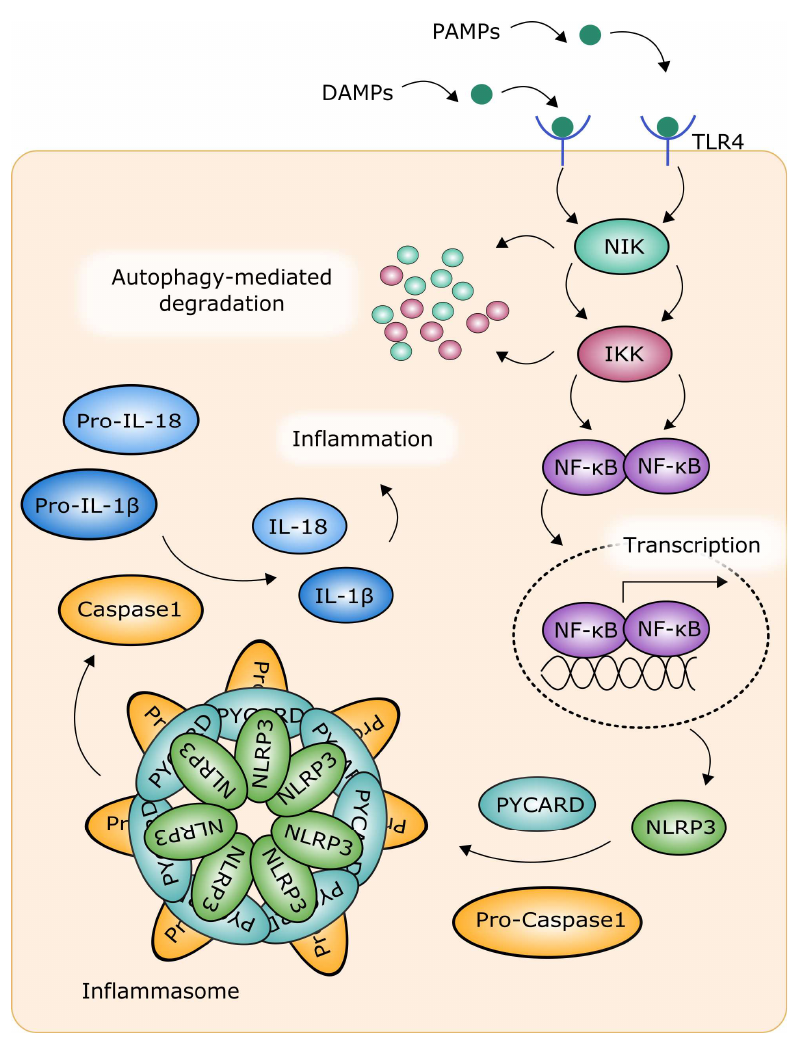
Figure 5. The inflammasome and the interplay between autophagy and NF-κB-mediated inflammation. See the text for more details. PYCARD (apoptosis-associated speck-like protein See the text for more details. PYCARD (apoptosis-associated speck-like protein containing a caspase containing a caspase recruitment domain); DAMP: damage-associated molecular pattern; IKK: IκB kinase; IL: interleukin; NF-κB: nuclear factor kappa-light-chain-enhancer of activated B cells; NIK: recruitment domain); DAMP: damage-associated molecular pattern; IKK: I κ B kinase; IL: interleukin; NF-κB-inducing kinase; NLRP3: NLR family pyrin domain containing 3; PAMP: pathogen-associated NF- κ B: nuclear factor kappa-light-chain-enhancer of activated B cells; NIK: NF- κ B-inducing kinase; pattern; TLR4: Toll-like receptor 4. NLRP3: NLR family pyrin domain containing 3; PAMP: pathogen-associated pattern; TLR4: Toll-like receptor